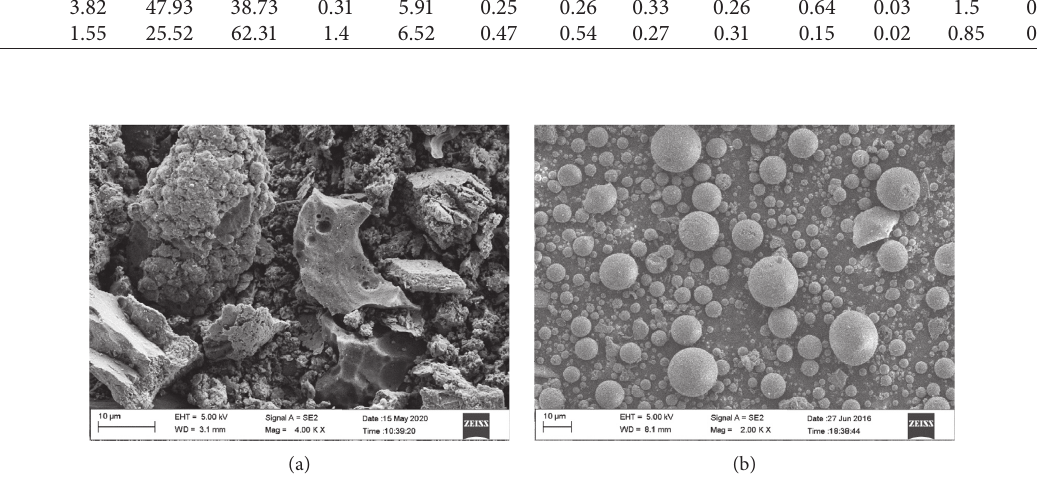
Figure 2: Microstructure of the FA: (a) FA1 and (b)